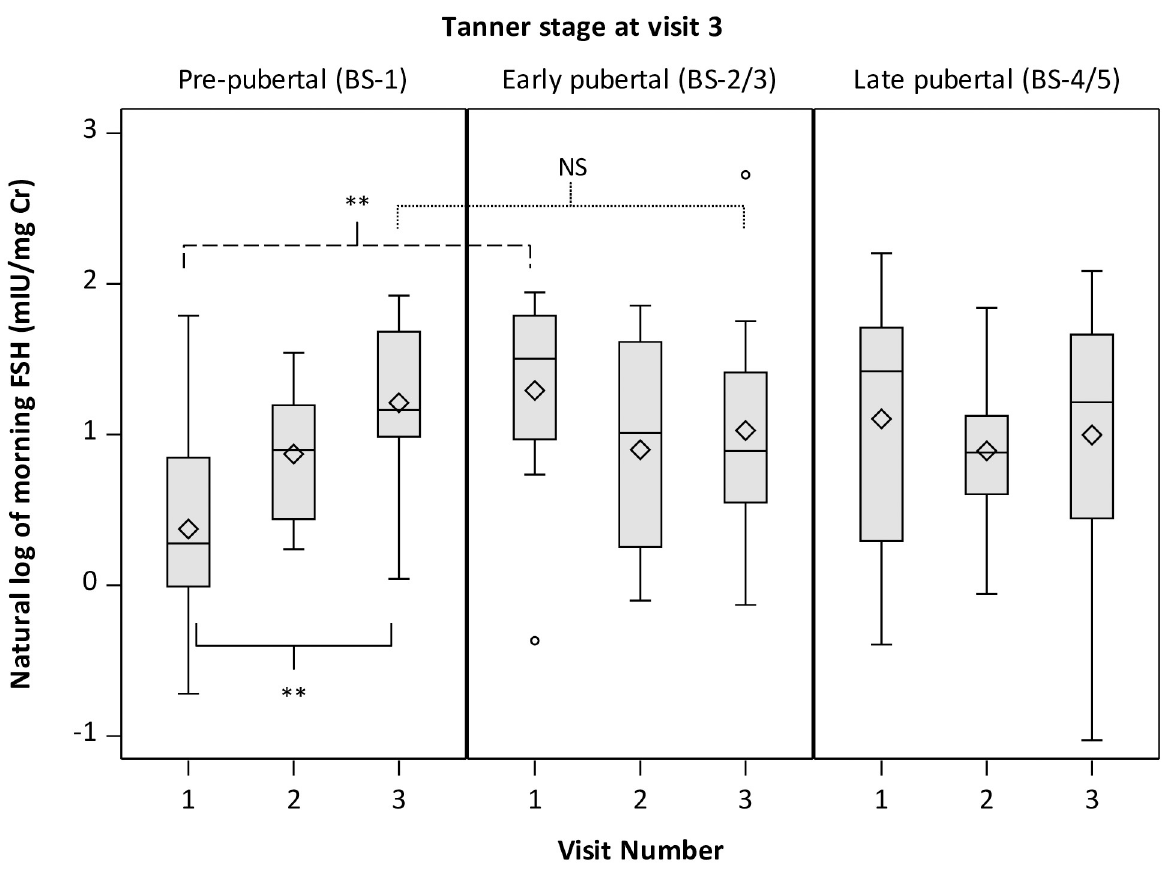
Fig 1. Morning urinary FSH levels in girls by Tanner breast stage and visit. Girls are classified as pre-pubertal (BS-1), early pubertal (BS-2/3) or late pubertal (BS-4/5) based on self-report of Tanner breast stage at visit 3. P values from repeated measures analysis adjusted for BMI Z-score shown for V3 vs. V1 levels among BS-1 girls (solid), BS-2/3 vs. BS-1 at V1 (dashed) and BS-2/3 vs. BS-1 at V3 (dotted). NS = p � 0.05; � p < 0.05; �� p < 0.01.